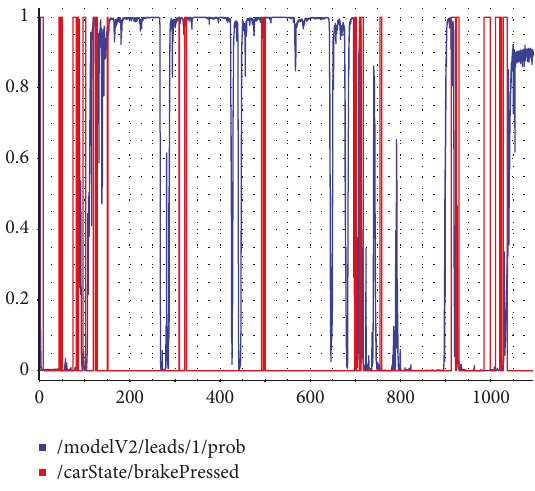
Figure 18: T1D4 lead car detection and braking.